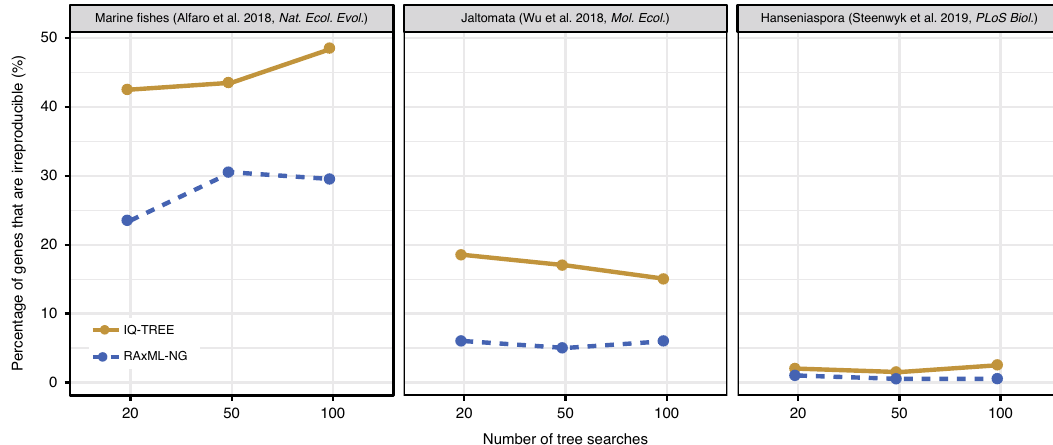
Fig. 4 Effect of a number of tree searches on irreproducibility of single-gene trees. Three representative studies in animals (marine fi shes: 1001 genes and 120 taxa from Alfaro et al. 65 ), plants (Jaltomata: 6431 genes and 15 taxa from Wu et al. 68 ), and fungi ( Hanseniaspora : 1033 genes and 29 taxa from Steenwyk et al. 69 ) were used to examine the impact of different numbers of tree searches on the reproducibility of gene phylogenies. To reduce the computational burden of the analysis, we sampled the fi rst 200 genes from each data set. The percentages of the 600 genes whose phylogenies are irreproducible when we ran two replicates (Run1 and Run2) on two separate nodes (i.e., each analysis was run on a 2-CPU node, but Run1 was executed on a different node than Run2) with an increasing number of tree searches on the CHTC cluster using IQ-TREE (in yellow) and RAxML-NG (in blue), respectively, are shown. These results suggest that increasing the number of tree searches used in our analyses has little effect on the irreproducibility of single-gene phylogenetic trees in both programs. All gene trees, log fi les, and statistics of the results, are available on the fi gshare repository: https://doi. org/10.6084/m9. fi